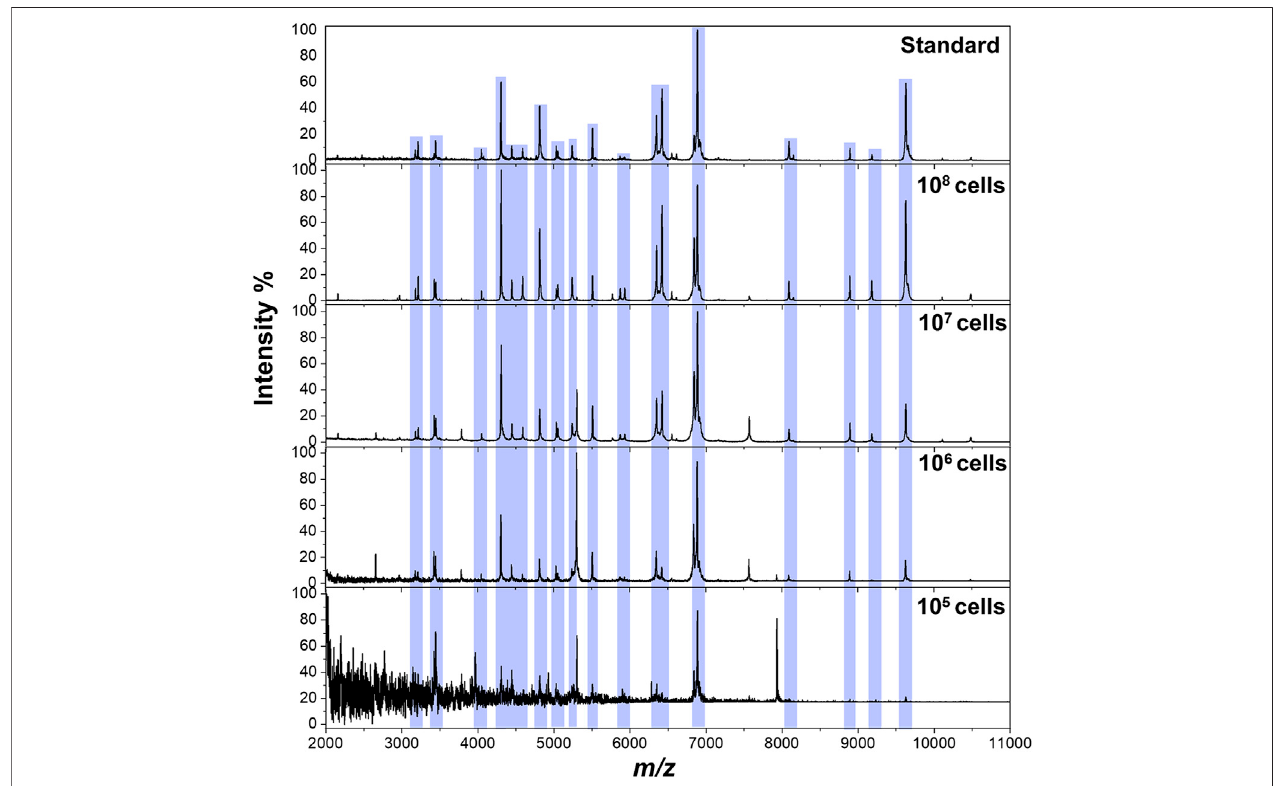
FIGURE2| MALDI-TOFMSspectraof S.aureus obtainedfrompuresolution (top) andenrichedbyFc-MBL@Fe 3 O 4 from1 mlbuffersolutionatdifferentamounts.